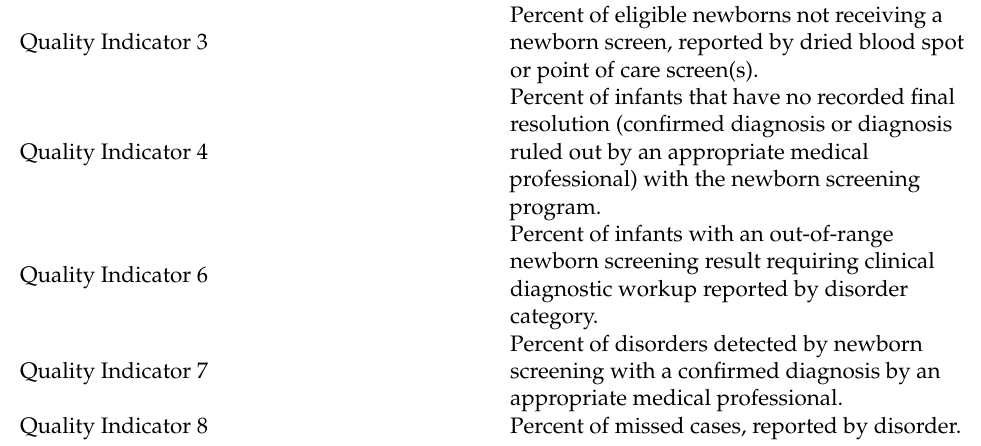
Table 1. NewSTEPs Quality Indicators relevant to newborn screening follow-up. Quality Indicator 3